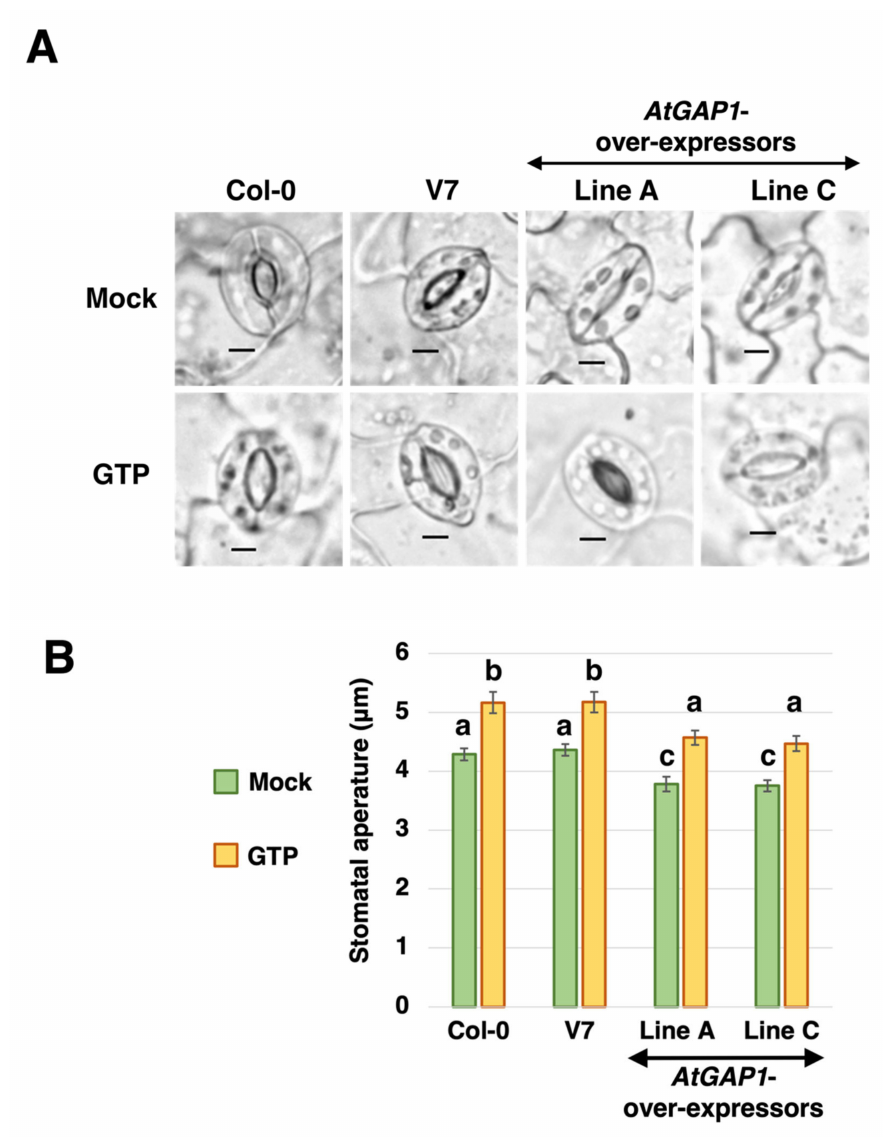
Figure 7. AtGAP1 -overexpression reduces stomatal aperture in Arabidopsis with the effect being reversible by additional GTP. Detached rosette leaves of four-week-old Arabidopsis plants, including wild type, empty vector control (V7), and AtGAP1 -overexpressor lines A and C, were treated with or without (mock) 200 µ M GTP under light for 2 h. ( A ) Representative images of guard cells observed using a light microscope. Scale bar: 5 µ m. ( B ) Stomatal apertures of wild type, empty vector control (V7), and AtGAP1 -overexpressor lines A and C treated with or without (mock) 200 µ M GTP. For each line, the stomatal apertures of ≥ 25 pairs of guard cells were measured. Error bar: standard error of all the cells measured. A similar trend was observed in another biological replicate (Figure S9). Different letters above the bars indicate significant differences at p < 0.05, analyzed using one-way ANOVA followed by post-hoc Tukey honestly significant difference (HSD)